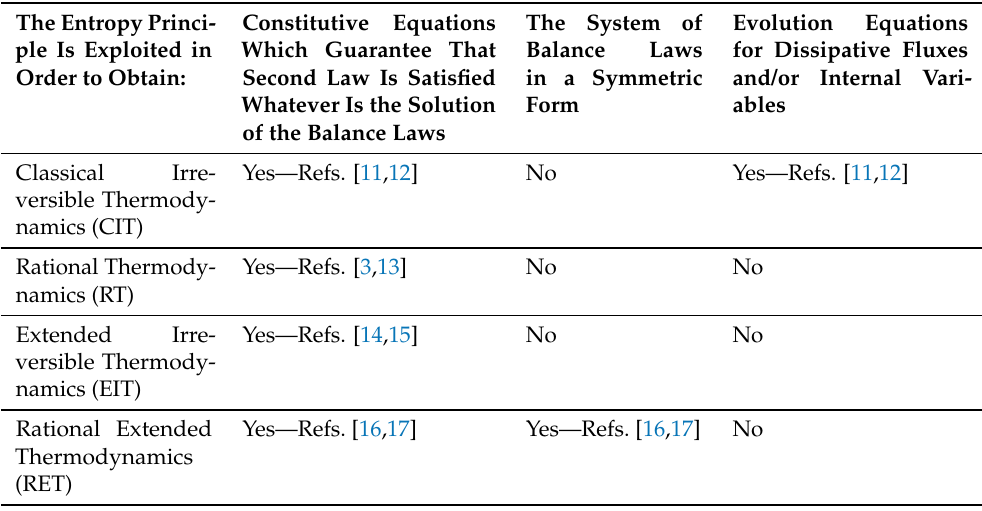
Table 2. Tasks achieved by exploitation of the entropy principle in the different thermodynamic